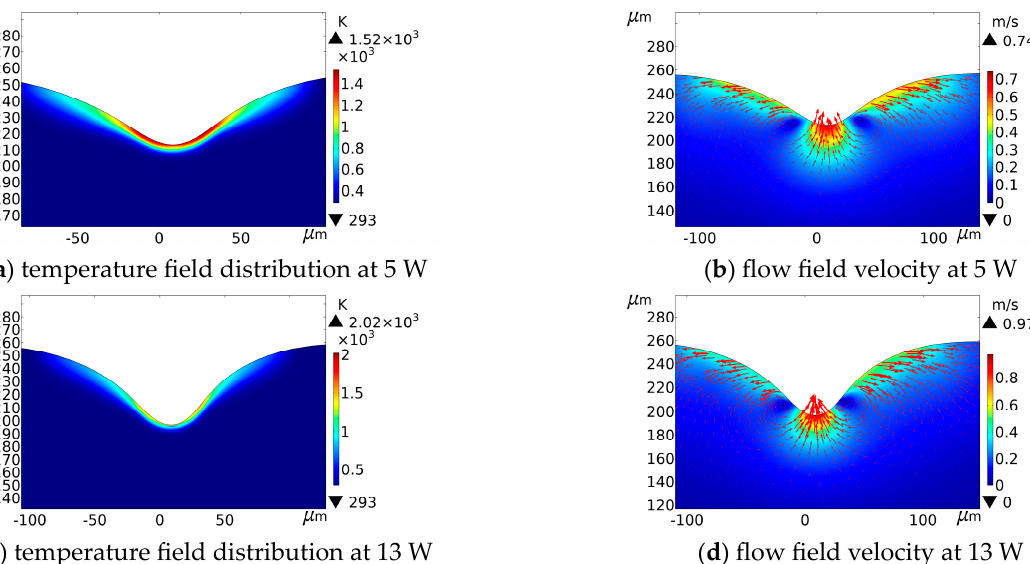
Figure 11. Temperature field distribution and flow field velocity at different average powers (Pulse